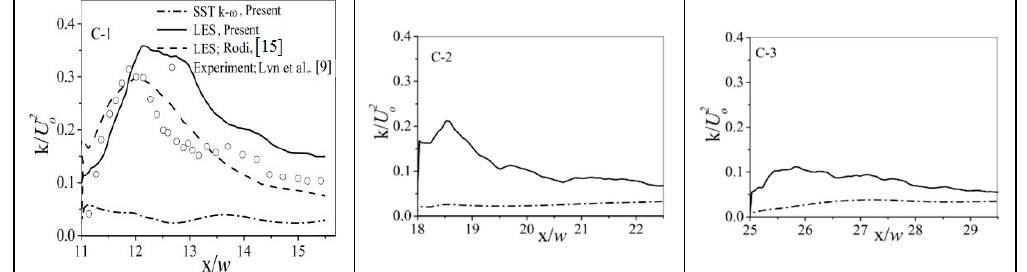
Fig. 14: Time-Averaged Turbulent Kinetic Energy (k/U o2 ) in the Wake Centreline of Case-II (a) C-1, (b) C-2, (c)